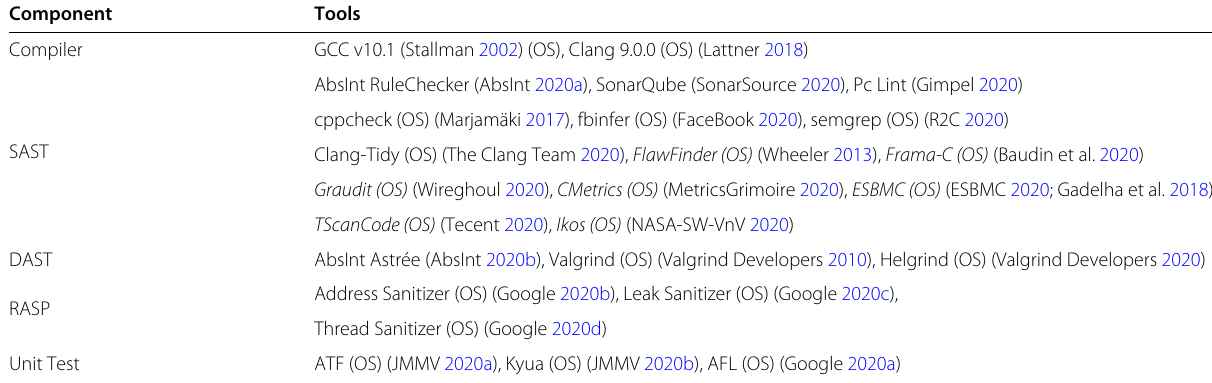
Table 1 Security assessment tools